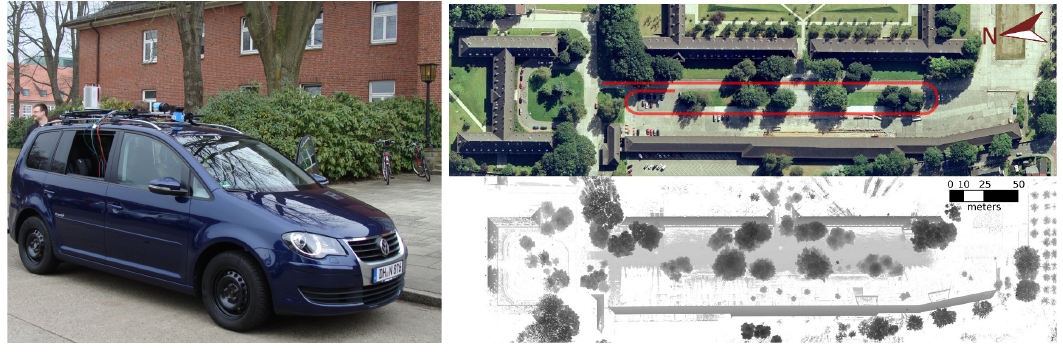
Figure 4. ( Left ) The TopScan GmbH mobile laser scanner using the Lynx Mobile Mapper